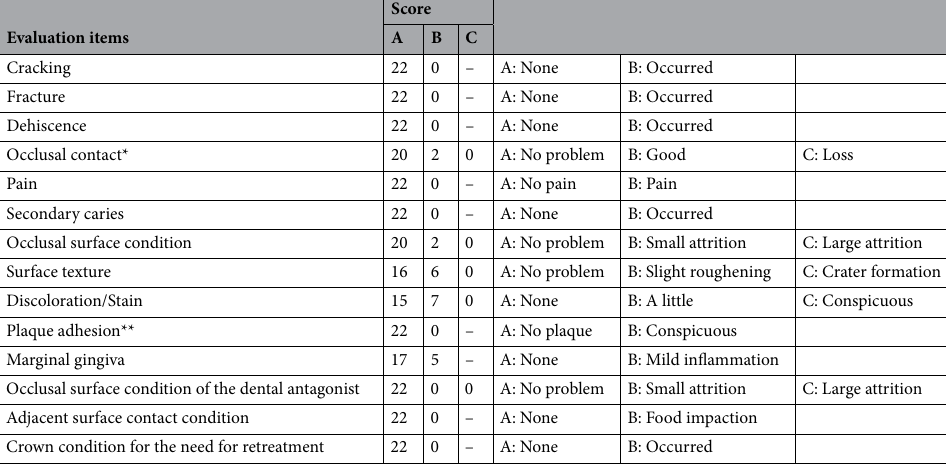
Table 4. Conditions of PEEK crown in the oral cavity at six months after cementation. Assessment was done by one dentist using a mouth mirror and a probe. The surface of PEEK crowns were dried with compressed air and the plaque was visually examined under artificial light. *No problem: point contact at the functional occiput, Good: surface contact at the functional occiput, Loss: no contact at the functional occiput. **No plaque: No obvious plaque adhesion, Conspicuous: Obvious plaque adhesion.